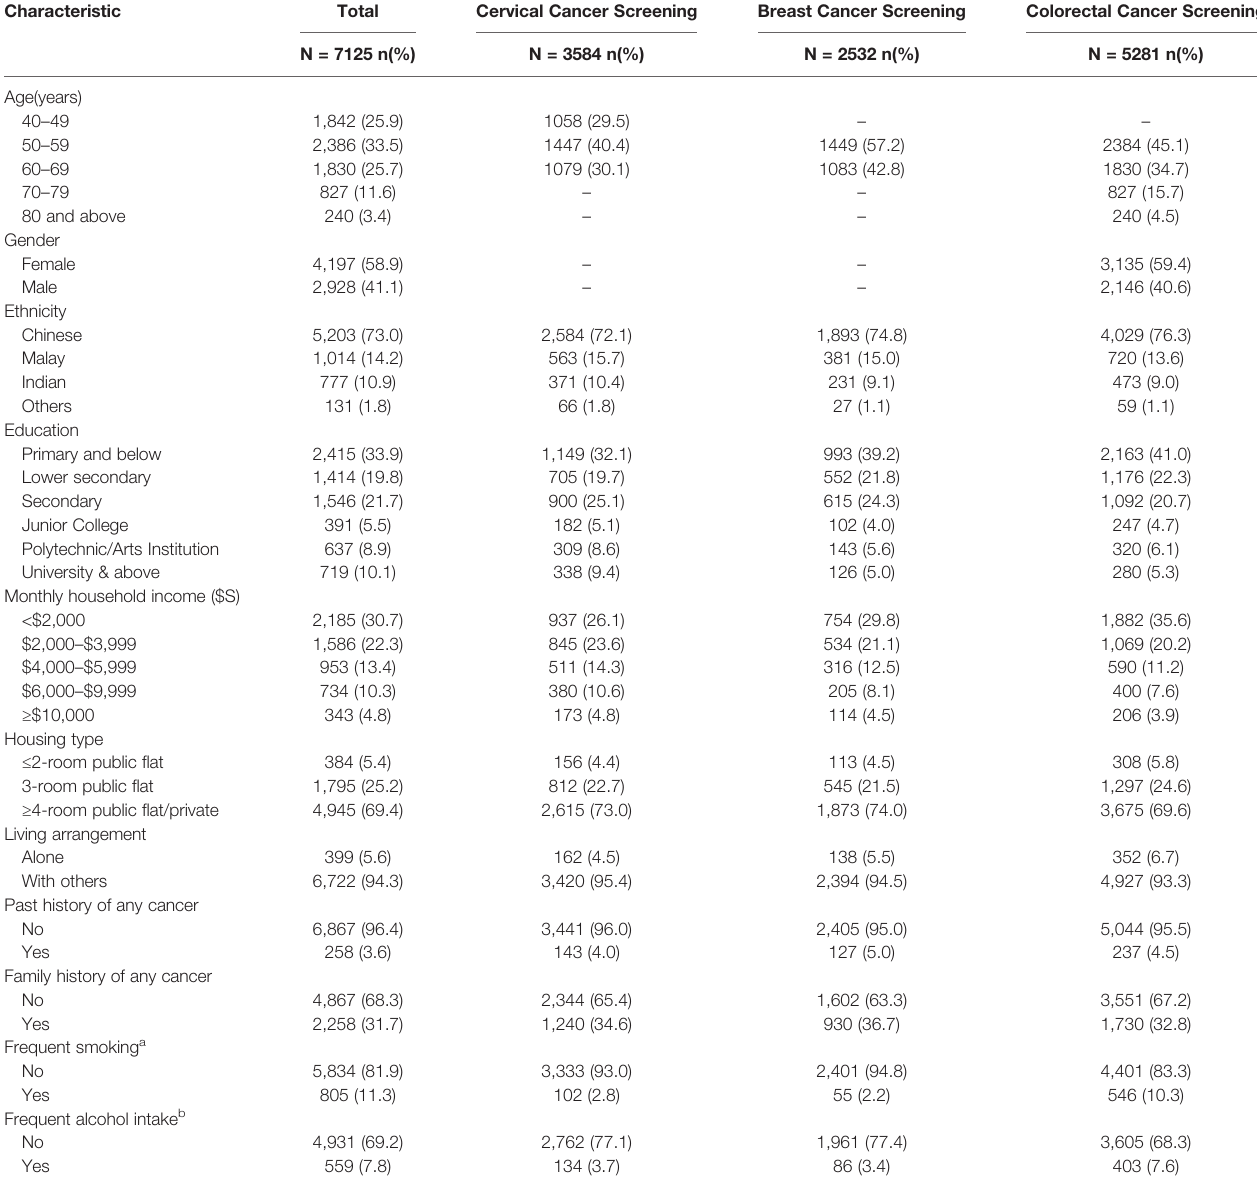
TABLE 1 | Characteristics of the study population by cancer screening eligibility